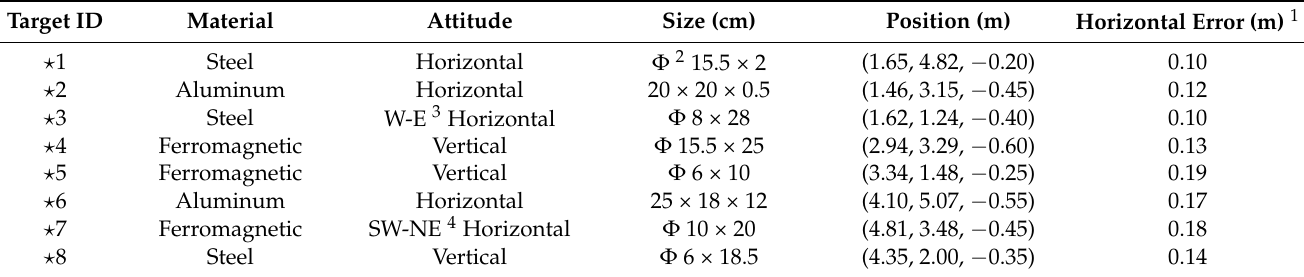
Table 3. Descriptions of targets used in the field experiment.